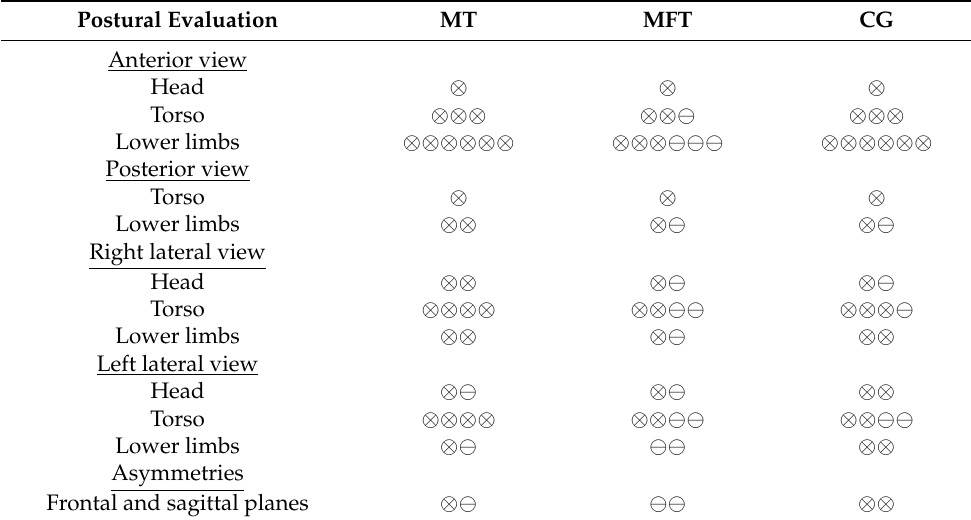
Table 4. Effect size of postural evaluation